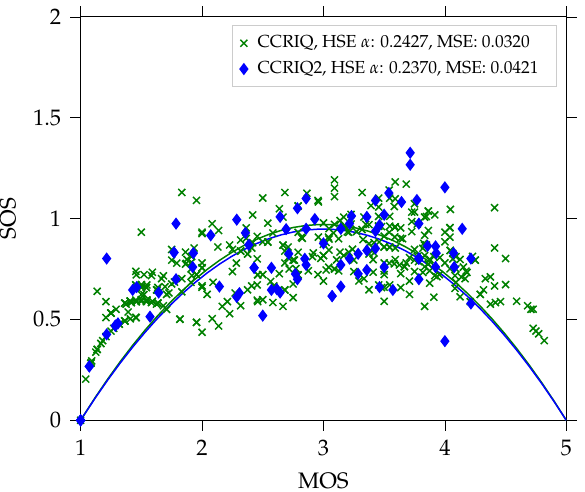
Figure 6. A comparison of HSE α parameters between the new CCRIQ2 and legacy CCRIQ data